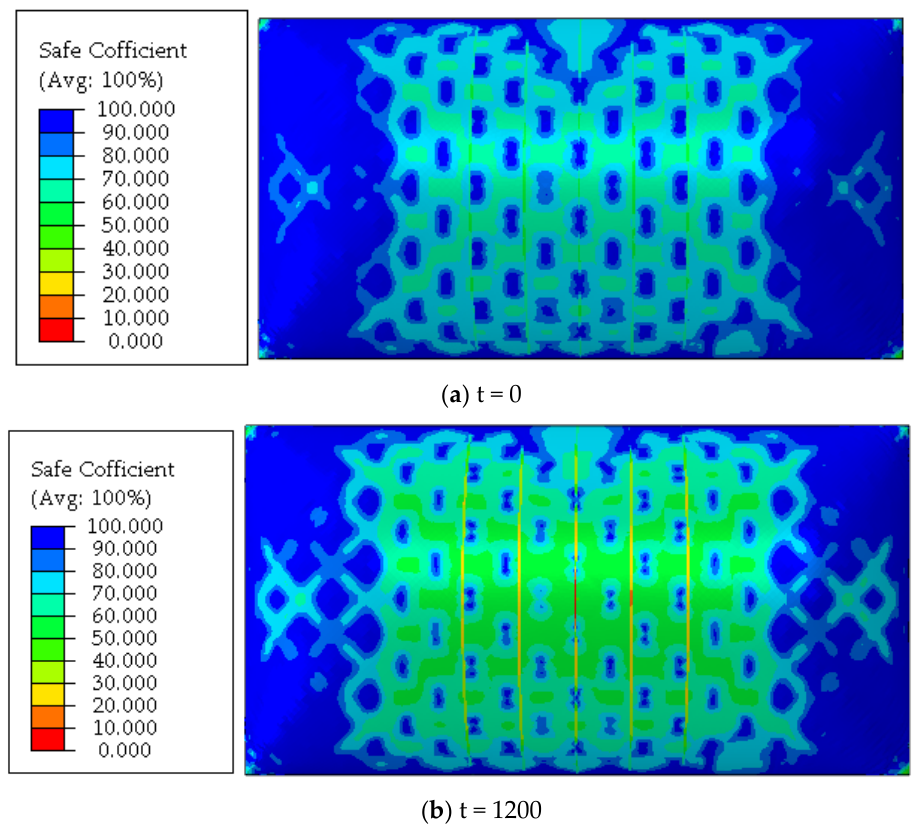
Figure 13. Safety factor of the membrane before and after fire.